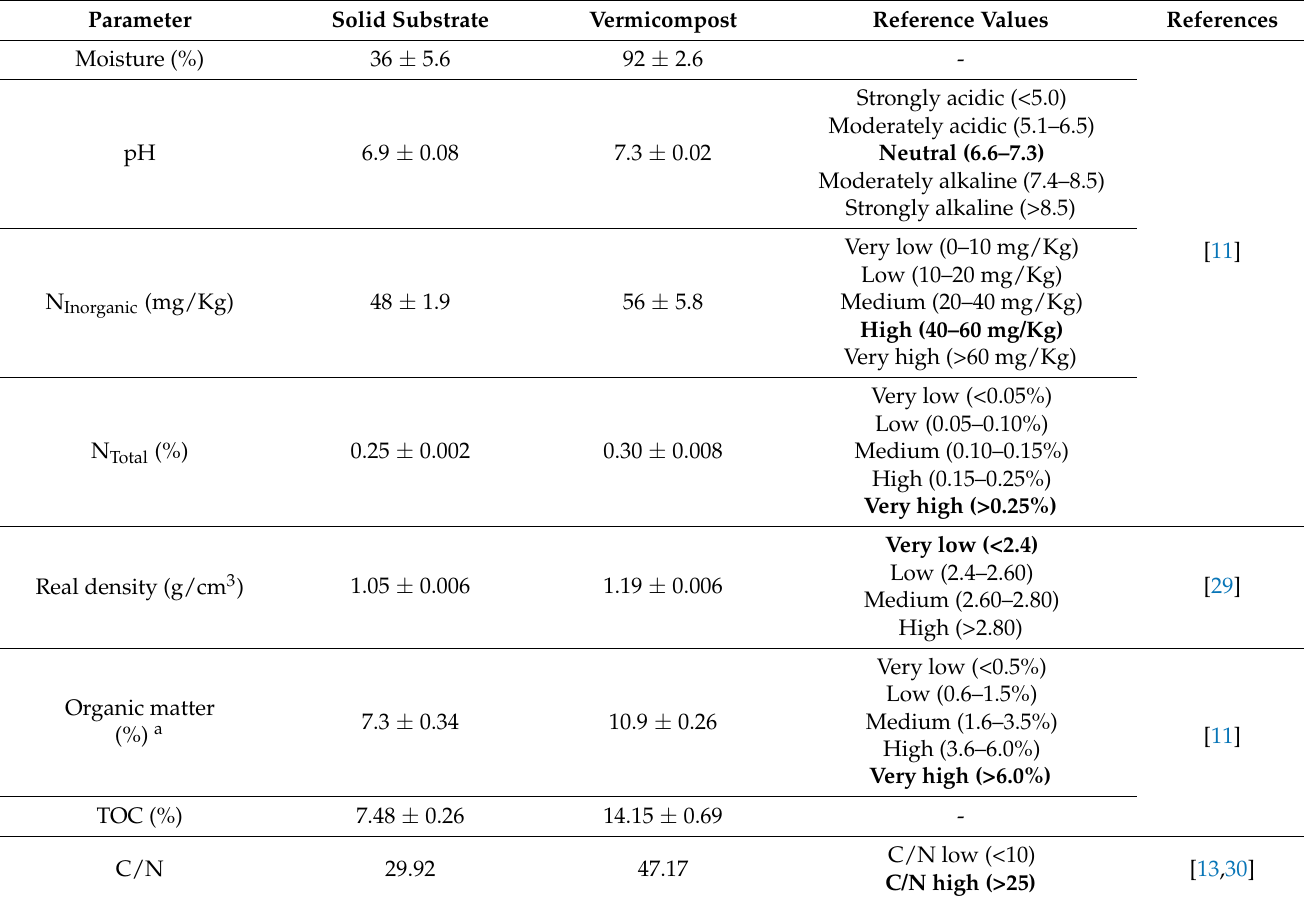
Table 2. Physicochemical characteristics of solid substrate and